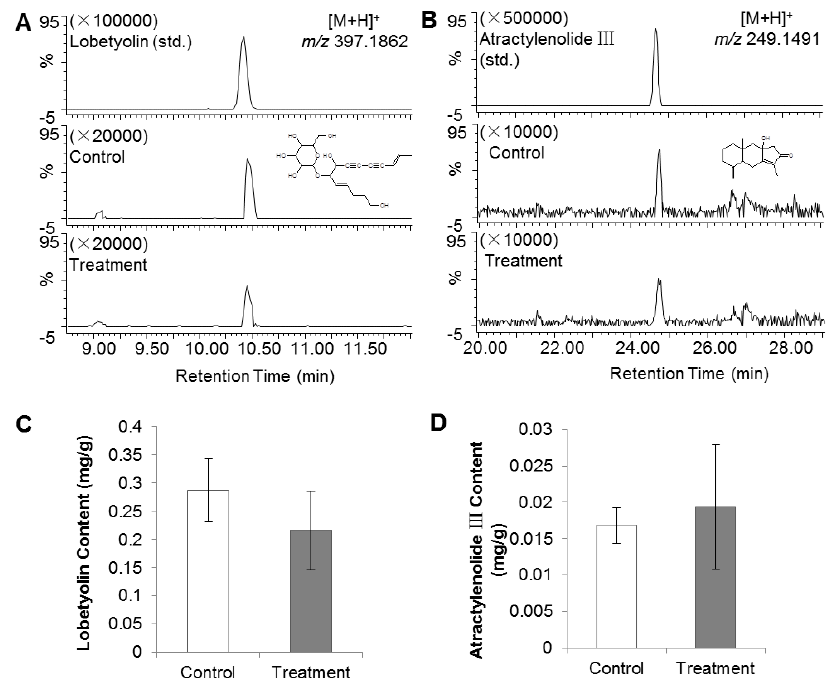
Figure 1. Effect of plant growth retardant (PGR) on lobetyolin and atractylenolide III contents in C. Radix samples. ( A ) Chromatogram comparison of lobetyolin standard, and control and treatment groups. Lobetyolin (std.), lobetyolin standard (20 ng/ µ L, m / z = 397.1862, RT = 10.43 min); control, untreated C. Radix sample; treatment, PGR-treated C. Radix sample. ( B ) Chromatogram comparison of atractylenolide III standard, control and treatment groups. Atractylenolide III (std.), atractylenolide III standard (10 ng/ µ L, m / z = 249.1491, RT = 24.68 min). ( C ) & ( D ) Lobetyolin and atractylenolide III contents in control and treatment groups (as calculated from peak areas of samples and the standard).